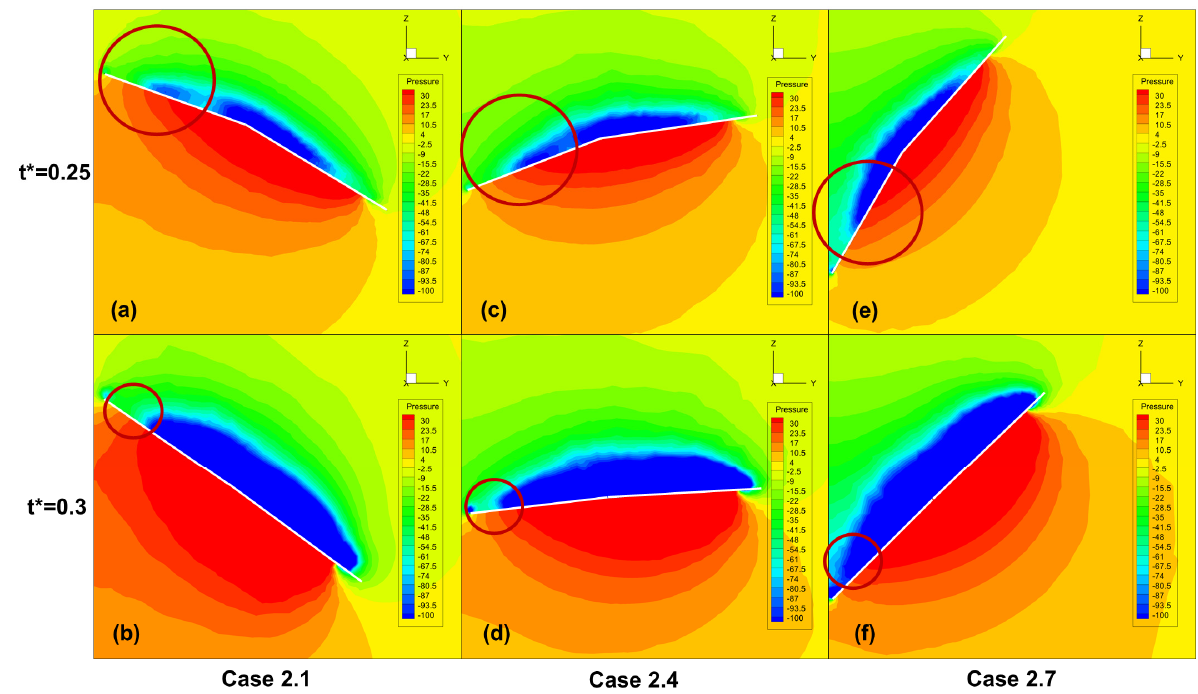
Figure 15. Spanwise pressure distribution of typical cases: ( a ) case 2.1 at t* = 0.25; ( b ) case 2.1 at t* = 0.3; ( c ) case 2.4 at t* = 0.25; ( d ) case 2.4 at t* = 0.3; ( e ) case 2.7 at t* = 0.25; ( f ) case 2.7 at t* = 0.3.